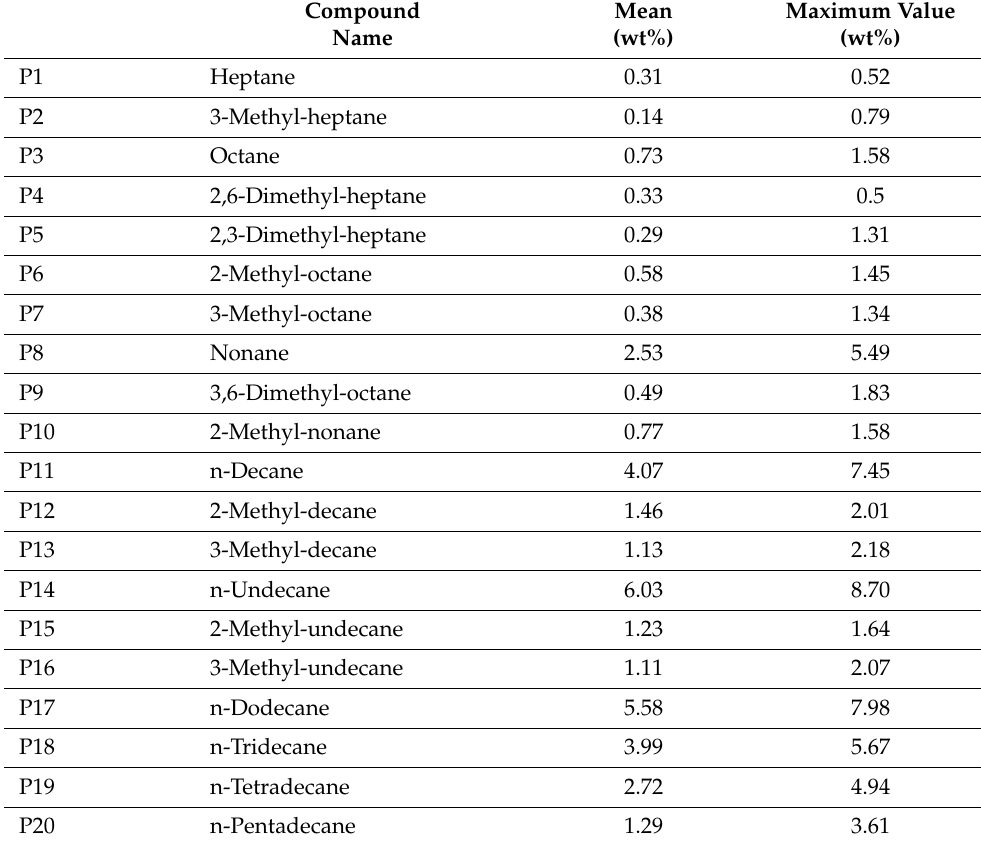
Table 3. Main individual components. Paraffinic